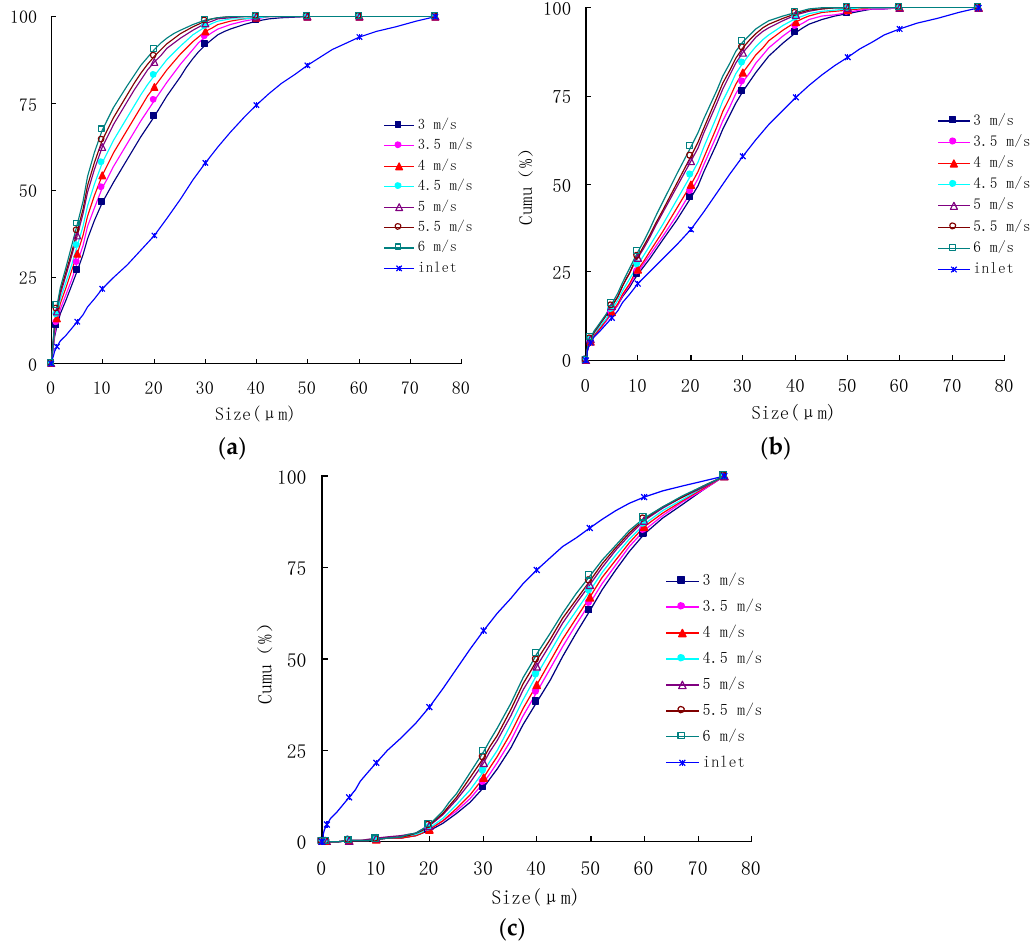
Figure 12. Particle size distribution of the product: ( a ) the overflow of first stage; ( b ) the overflow of second stage; ( c ) the underflow of second stage.